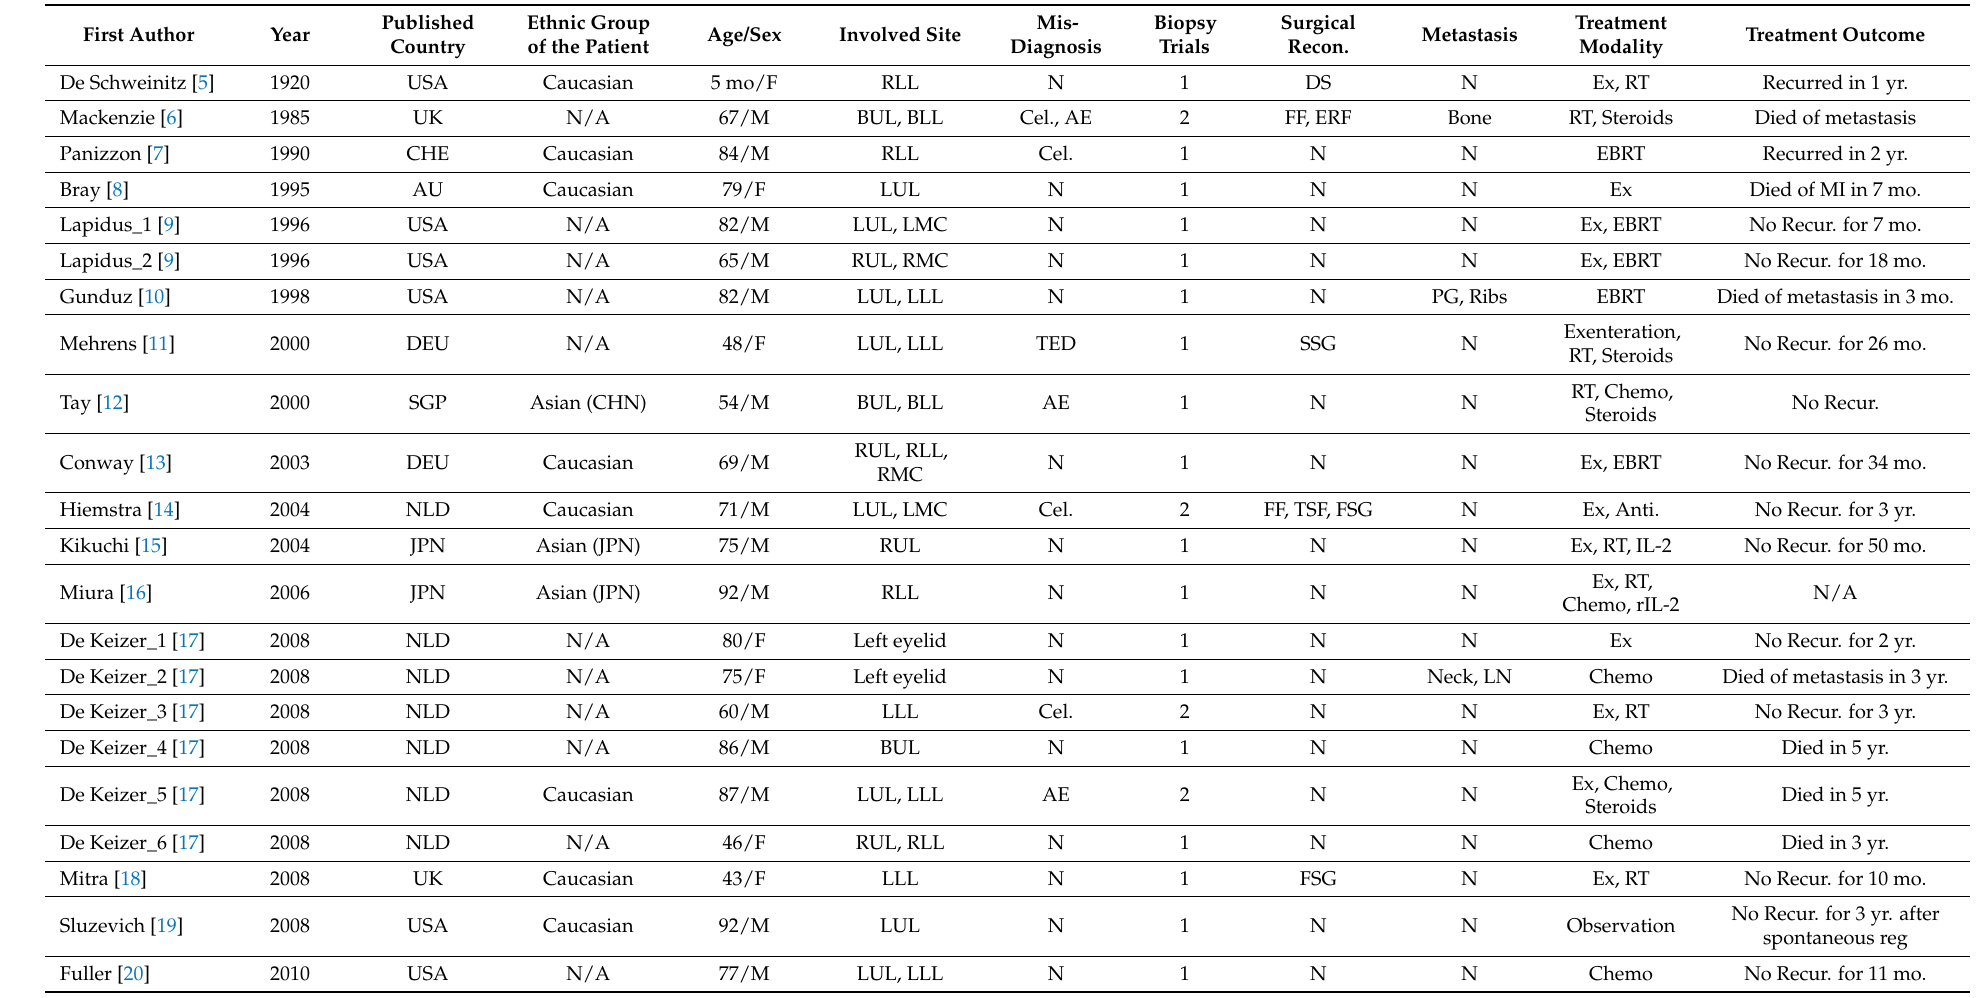
Table 1. Summary of the findings in the 42 published cases of eyelid